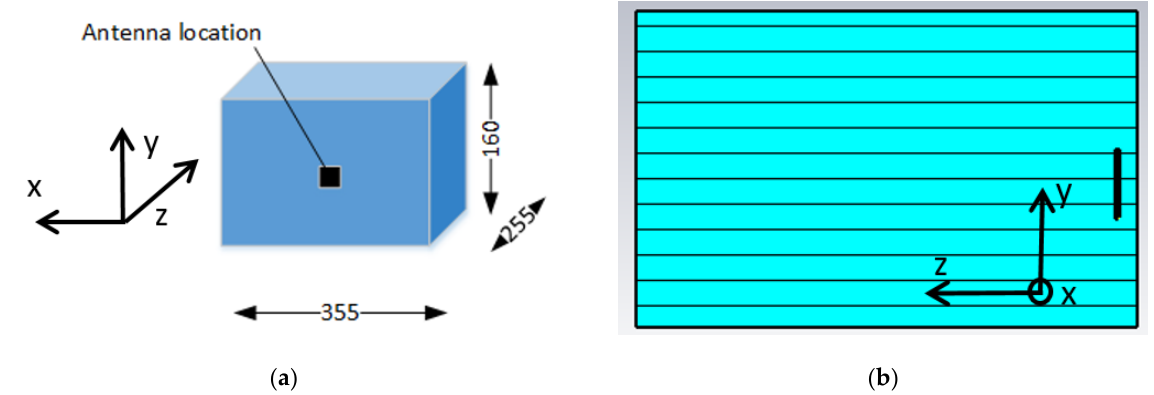
Figure A1. Placement of the antenna in the phantom. ( a ) Perspective and ( b ) side view. Units in mm.